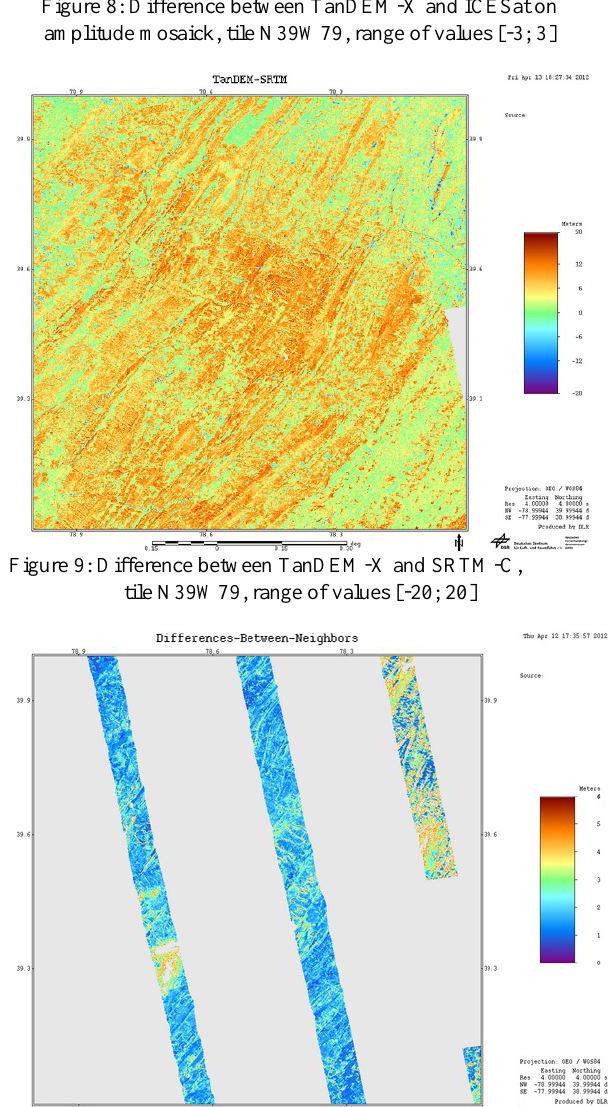
Figure 10: Difference between neighboring acquisitions, tile N39W79, range of values [0;